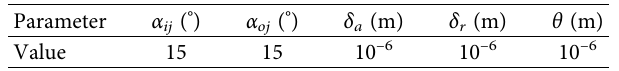
Table 2: Initial values of the parameters.